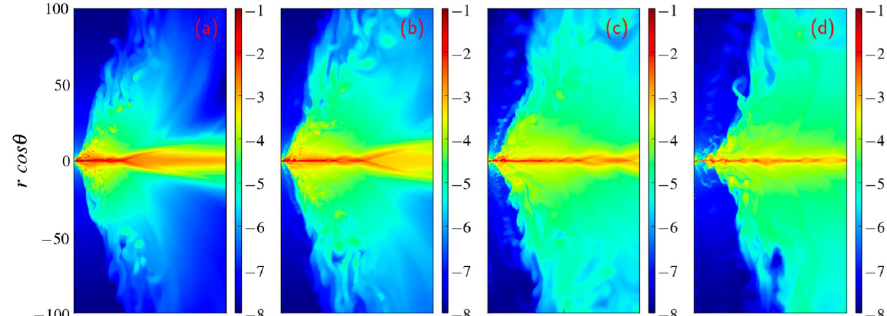
Figure 1. Evolution of 2D GRMHD simulations of a geometrically thin disk around a rotating black hole at t = 500 ( a ), t = 1000 ( b ), t = 2000 ( c ), and t = 4000 ( d ). The color contour is logarithmic normalized density ( ρ / ρ max ). Figure is reproduced with permission from Dihingia et al. MNRAS, 505, 3596 (2021)